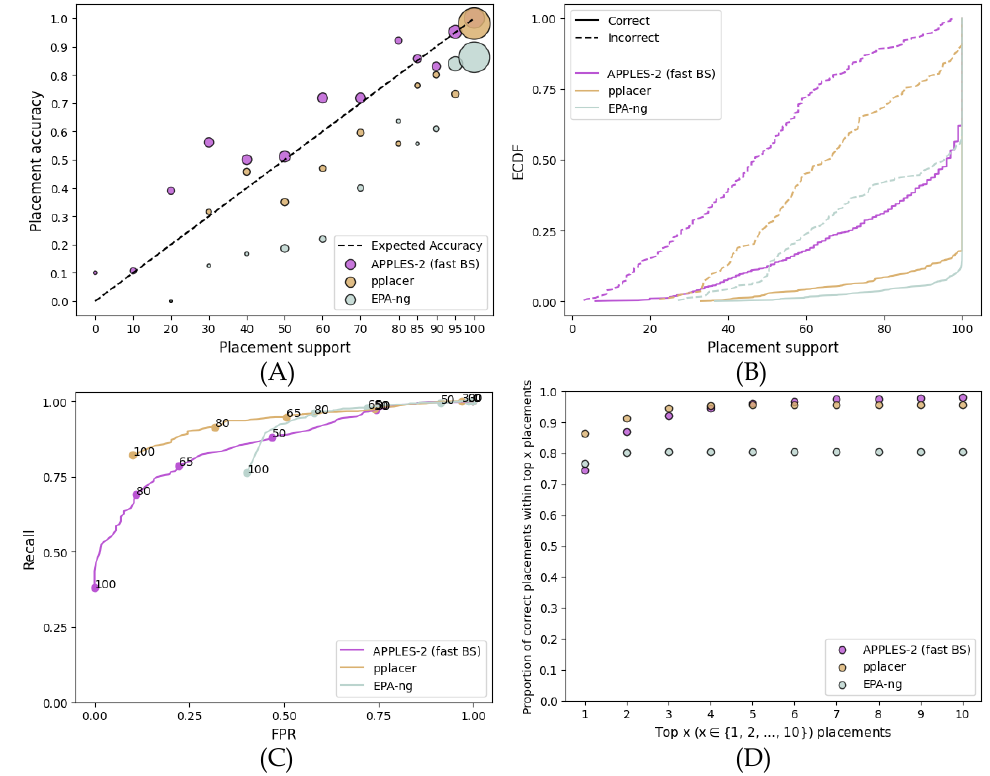
Figure 2. Comparison to EPA-ng and pplacer on the full-length RNASim dataset . Settings are similar to Figure 1. ( A ) Support vs. Accuracy, ( B ) ECDF, ( C ) ROC curves, ( D ) Frequency of correct placements within the top 1 ≤ x ≤ 10 highest support placements. MSE for support ≤ 70%: 0.02 for APPLES-2, 0.013 for pplacer, and 0.1 for EPA-ng; MSE for support > 70%: 0.001 for APPLES-2, 0.004 for pplacer, and 0.02 for